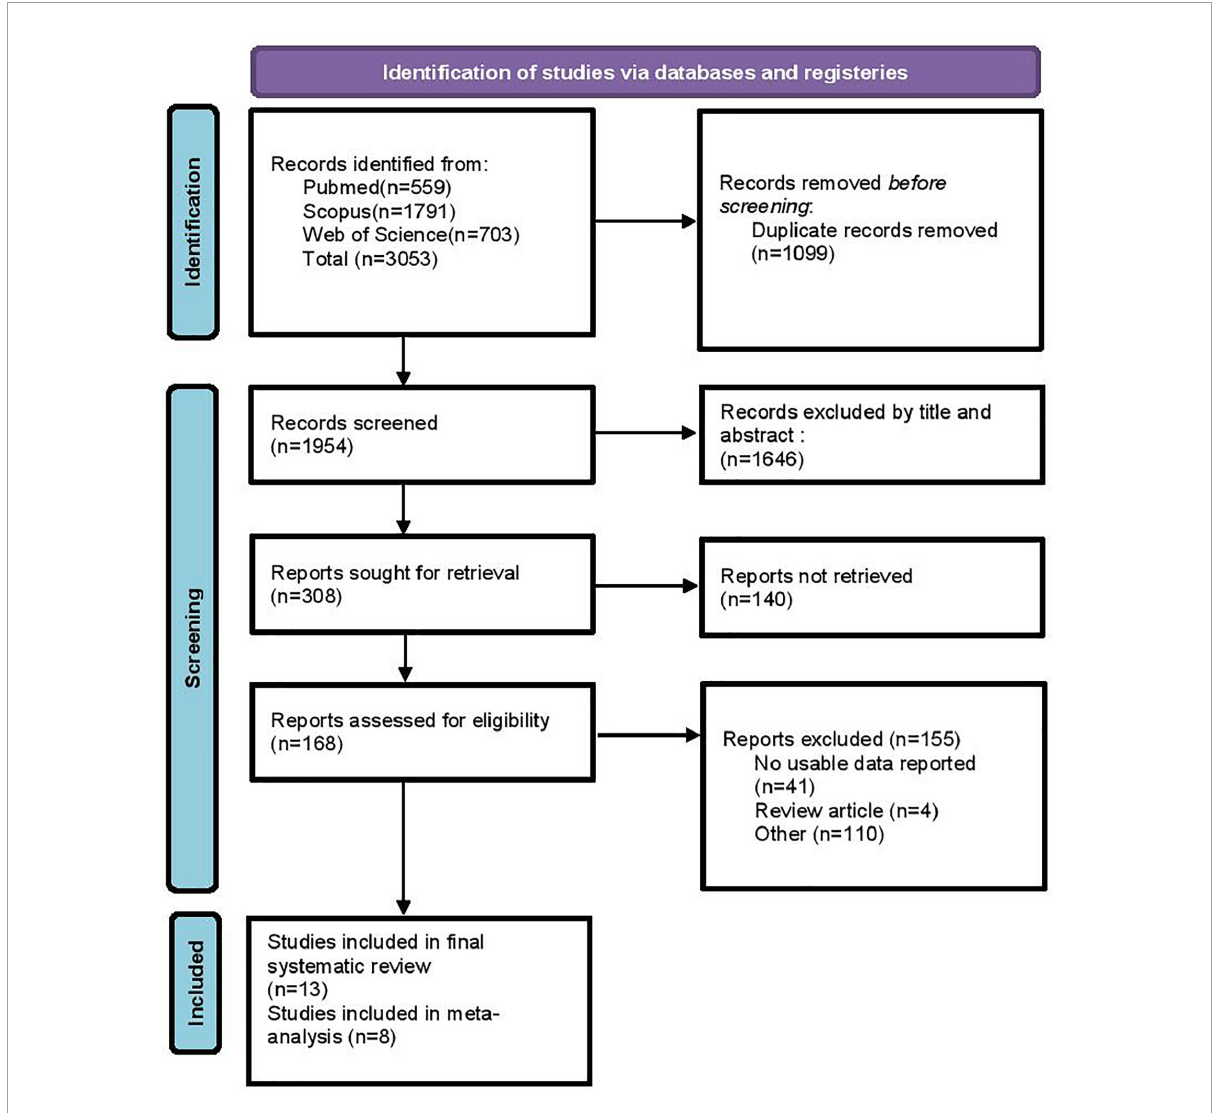
FIGURE1 Flow chart for study identification and selection. Based on PRISMA 2020.